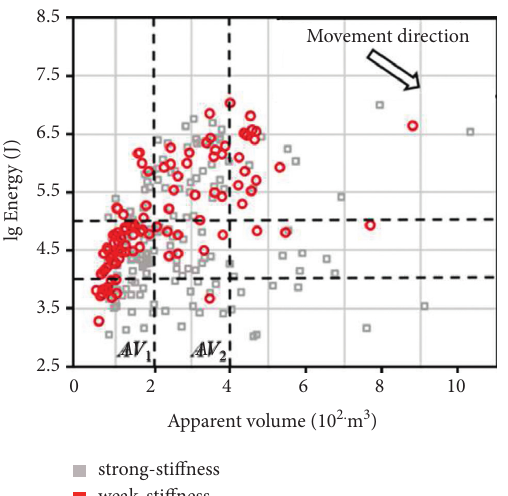
� 4 and (E) � 5 are the threshold 1 2